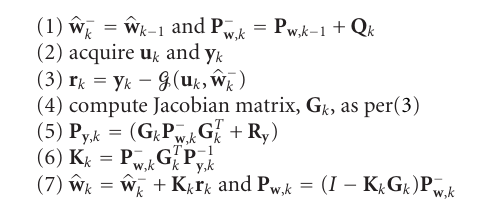
Algorithm 1: Basic steps of the extended Kalman filter.